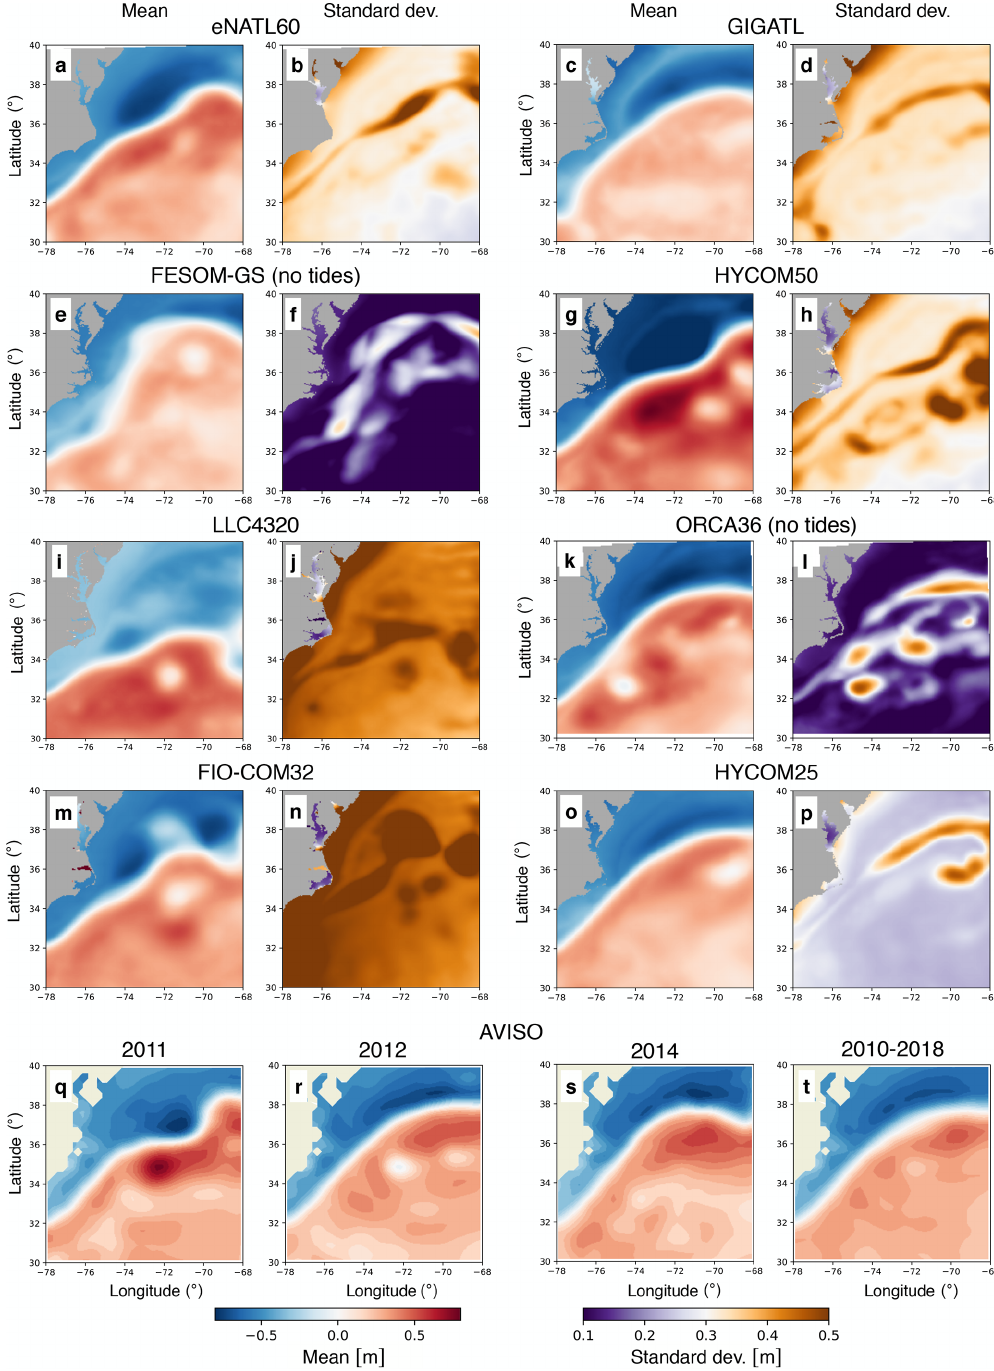
Figure 3. The temporal mean and standard deviation of ocean dynamic sea level in the GS separation region (Region 1) during the months of February, March, and April using hourly outputs of SSH from the models. The bottom row shows the seasonal mean of ADT fields from AVISO during the months of February, March, and April. Daily AVISO data were used to compute the seasonal mean for three individual years (2011, 2012, and 2014) and over 2010–2018. The spatial mean is subtracted from the temporal mean fields from the models and AVISO to ensure that the mean SSH/ADT anomaly fields are comparable (i.e., large-scale contributions have been